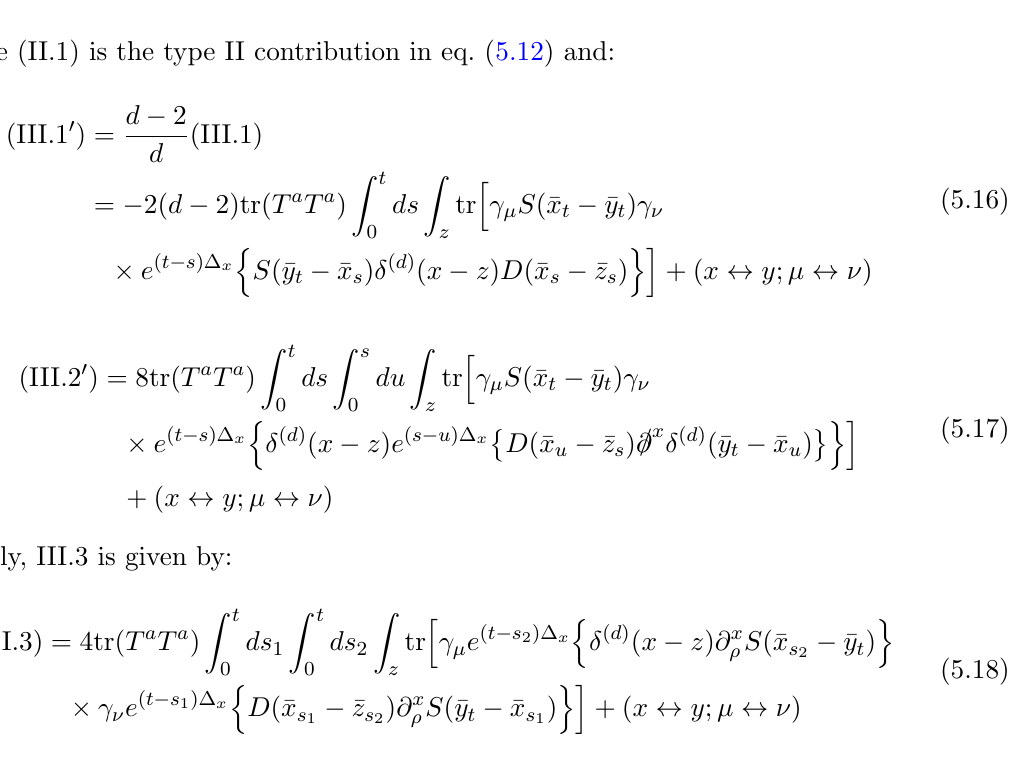
Figure 6. Type III diagrams for the evolved 2-point vector correlator at O ( g 2